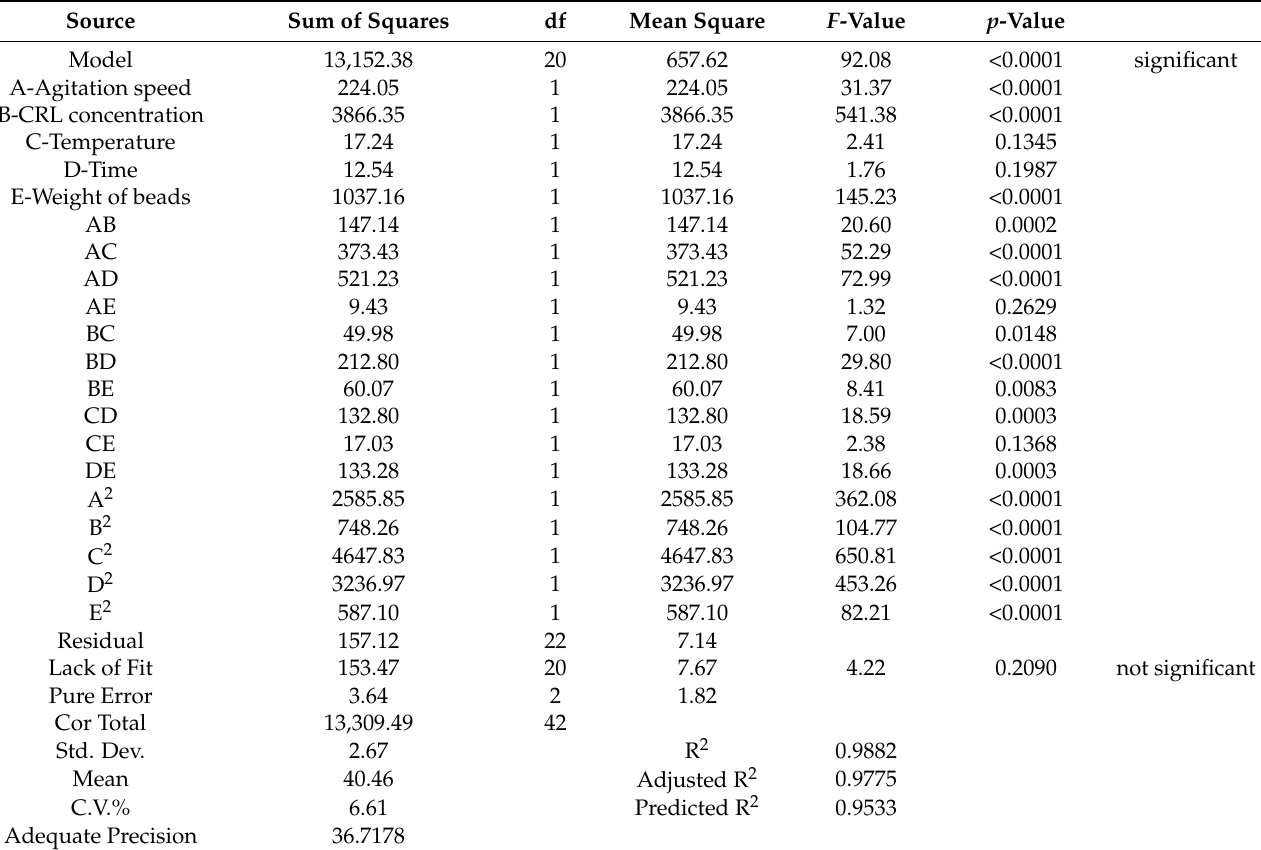
Table 3. ANOVA and fit statistics of the quadratic model for immobilization